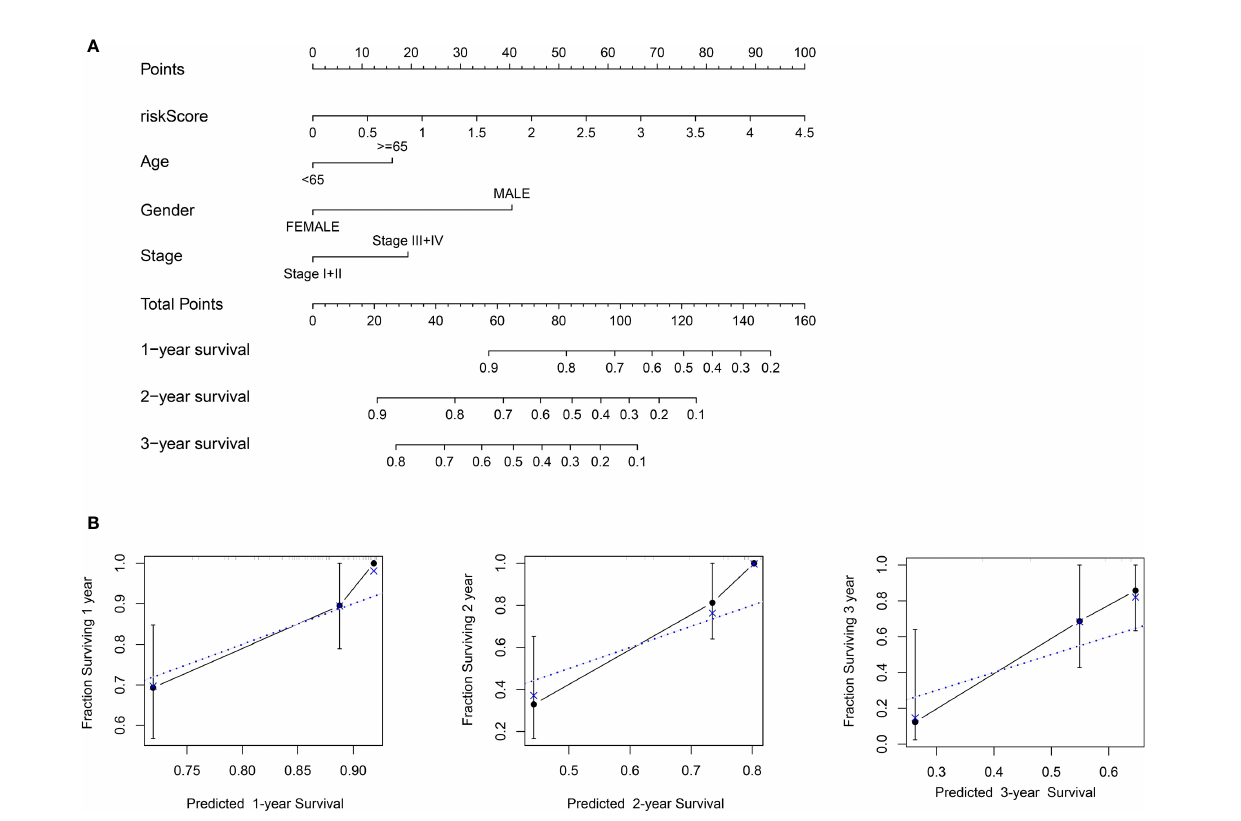
FIGURE 8 | Construction of the nomogram. (A) Nomogram predicting 1-, 2-, and 3- year survival based on risk score and other clinical parameters. (B) The calibration curves of nomogram between predicted and actual 1-, 2- and 3-year OS in the training cohort. The blue dotted line represents perfect prediction of the